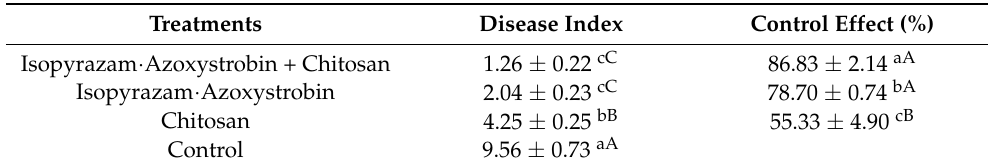
Table 2. The control effect of isopyrazam · azoxystrobin and chitosan against leaf spot disease of kiwifruit under field